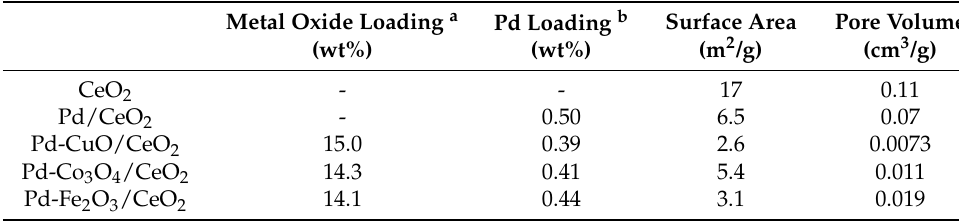
Table 1. Physicochemical properties of the prepared